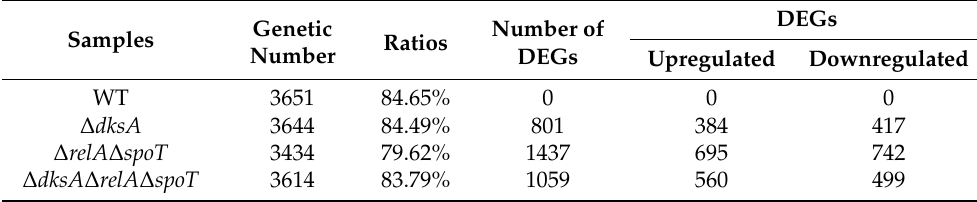
Table 1. Statistical analysis of